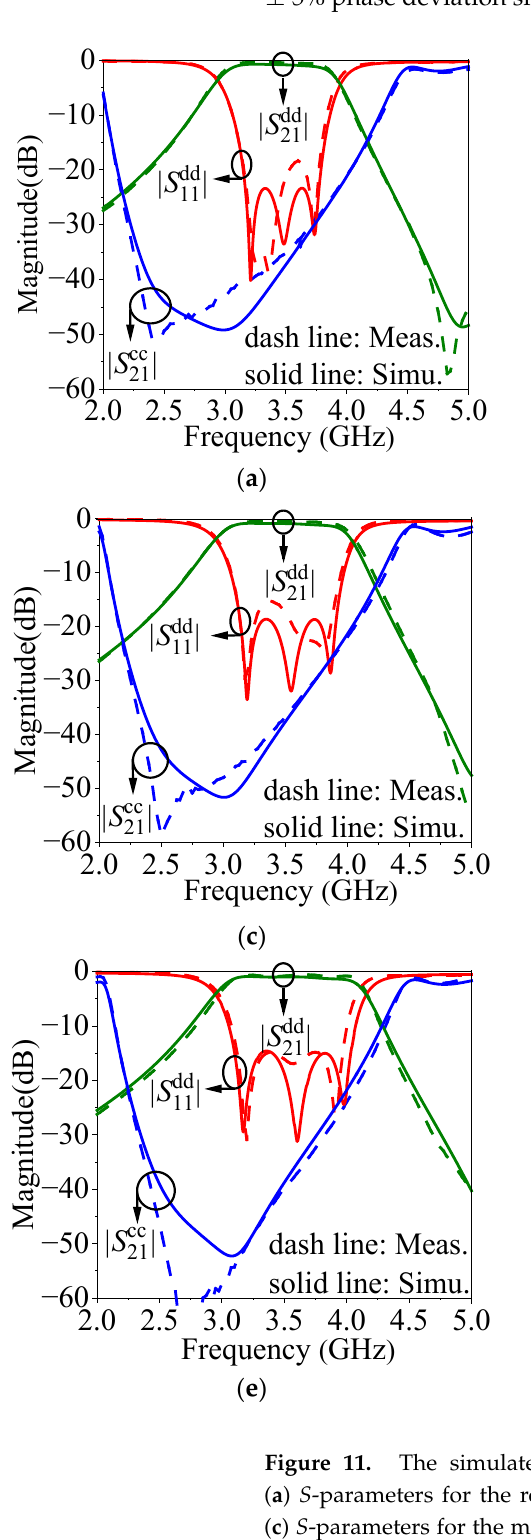
Figure 10. The photograph of the proposed balanced SIW phase shifter.